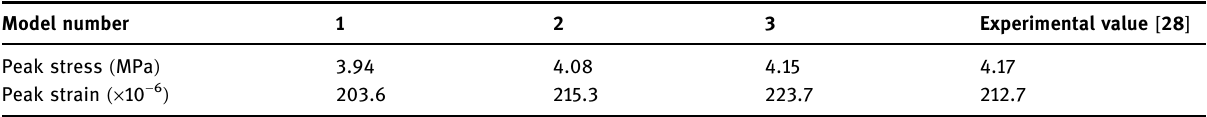
Table 4: Comparison of numerical simulation and experimental values